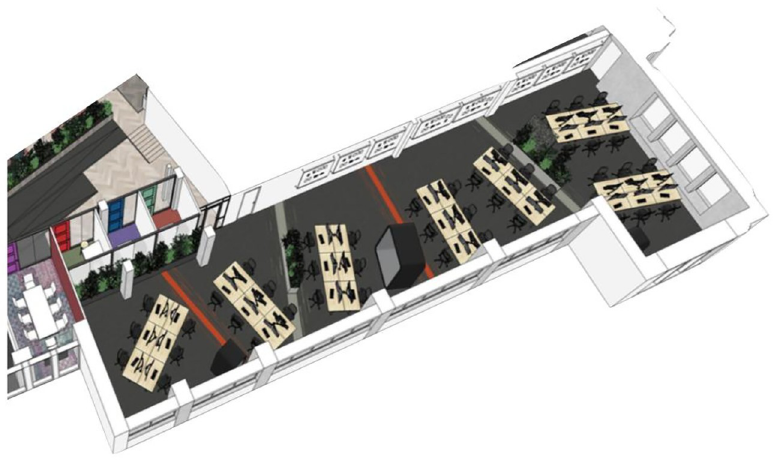
Fig 4. Zoned open plan. Digital render of the Zoned Open-plan design.